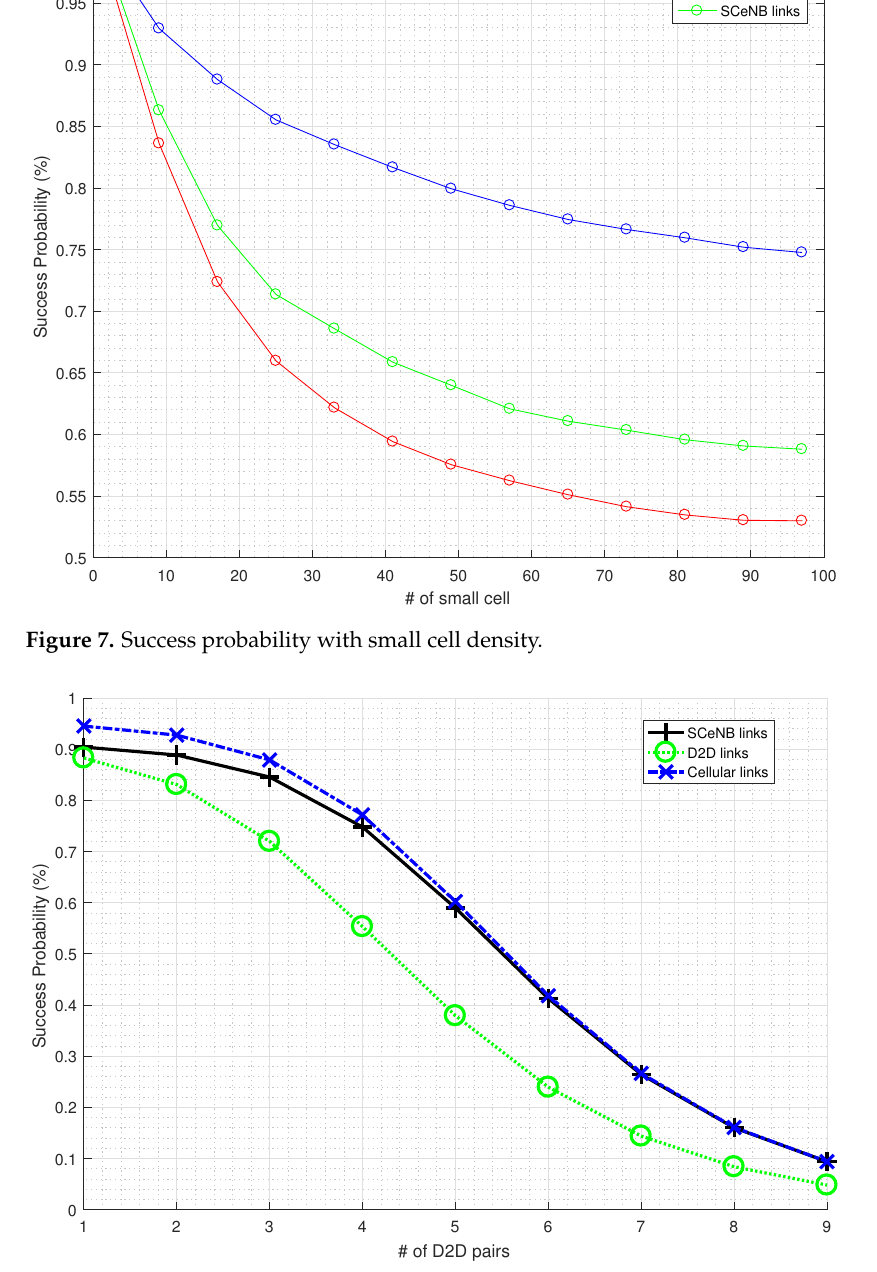
Figure 8. Success probability with D2D pair